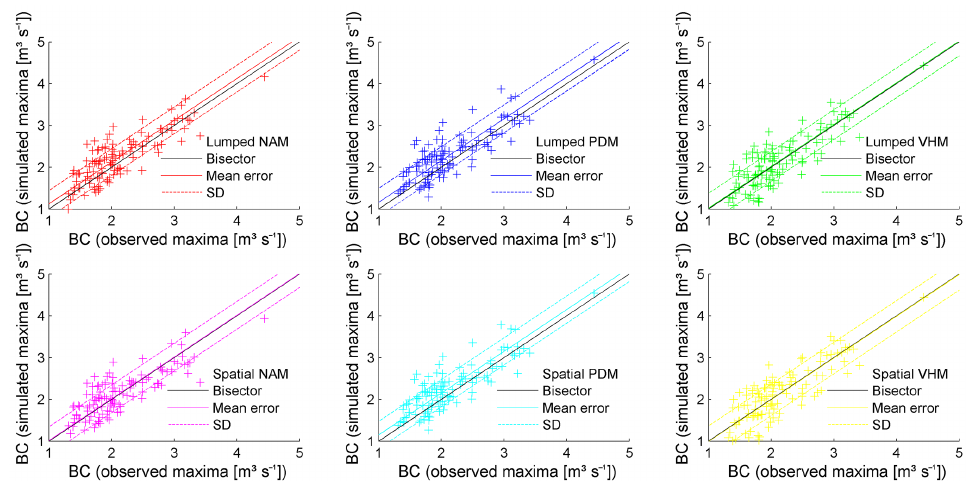
Figure 3. Simulated versus observed peak flows after Box-Cox transformation ( λ = 0 . 25), for the spatial and lumped models at the Grote Nete downstream catchment station, for the full simulation period 13 August 2002–31 December 2008.